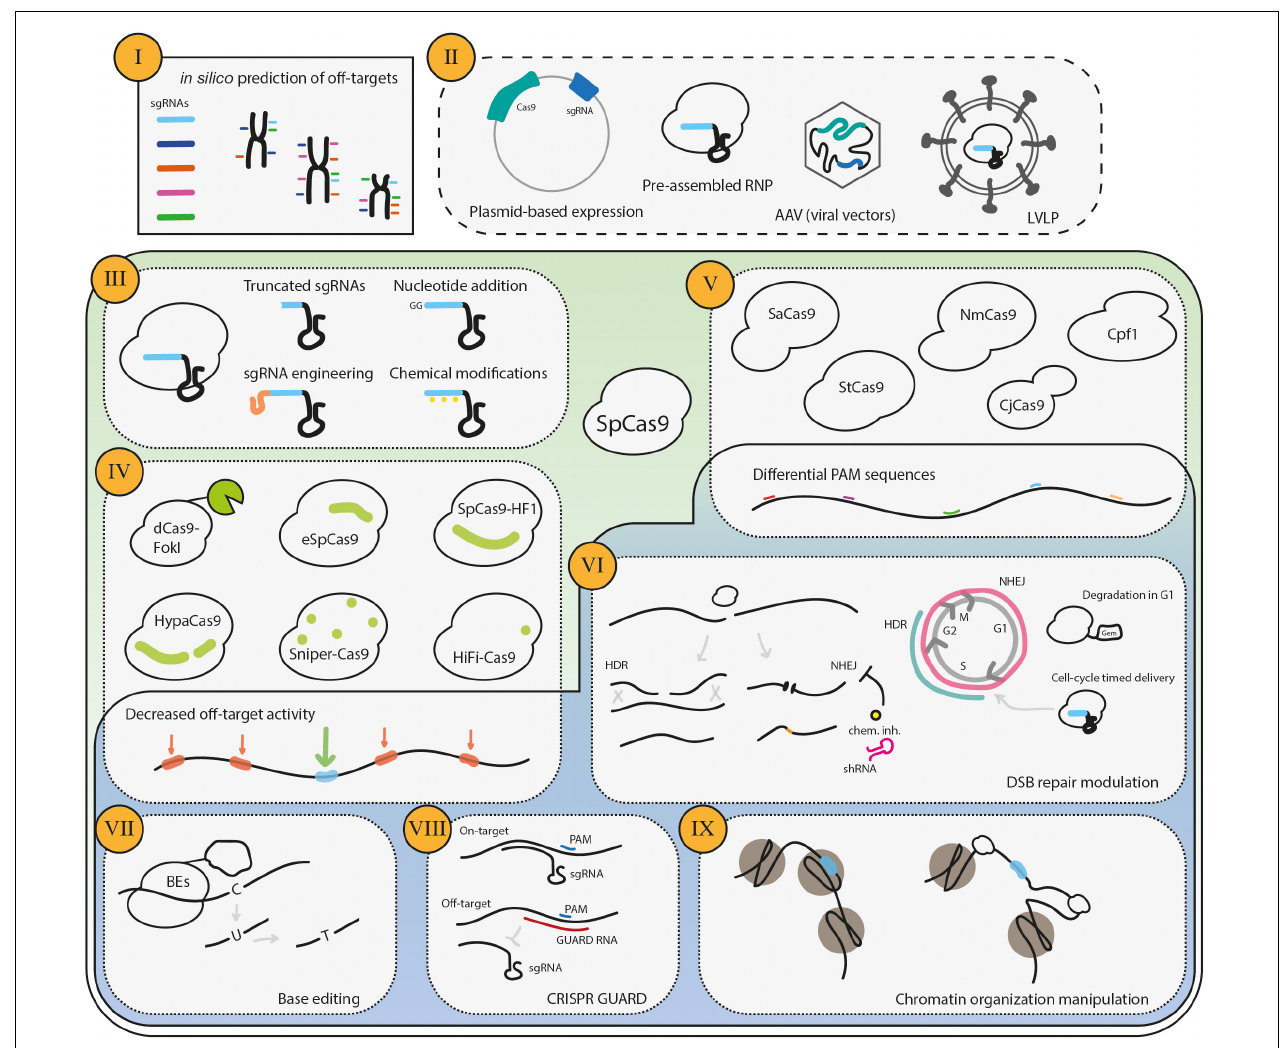
FIGURE 2 | Strategies to decrease CRISPR/Cas9 off-target activity. The procedures to mitigate undesired CRISPR/Cas9 gene editing start (I) in silico , namely in the design of the sgRNAs. Several bioinformatic tools are available to determine the predicted off-targets of a given sgRNA, and one should choose a sequence that has high theoretical on-target activity and a low probability of generating off-target DSBs. The second step is (II) the delivery type of the CRISPR/Cas9 system players, which determines how long the cell becomes exposed to the RNP complex. Furthermore, (III) the engineering of the sgRNAs is an efficient strategy to decrease off-target activity. One additional major focus has been to (IV) engineer the highly specific SpCas9 forms with decreased off-target activity. Moreover, (V) the SpCas9 orthologs have a repertoire of PAM specificities, which increases the options for suitable sgRNA and may also decrease the off-target activity if the complexity of the PAM is higher than that of SpCas9. (VI) Cas9-mediated DSBs may be repaired by the HDR or NHEJ pathways, which generate distinct repair products. As the HDR repairs the DNA damage restoring the original sequence, it has been argued and shown that the repair of off-targets by this pathway does not generate undesired gene edits. HDR repair is promoted either by pharmacological inhibition or cell-cycle-regulation. More recently, the use of Base Editors (VII) , where a catalytically dead Cas9 or a Cas9 nickase is fused to a cytidine deaminase that drives a single nucleotide modification, has the potential to reduce off-targets, due to sequence requirements and the lack of DSBs. The blockage of off-targets by GUARD RNAs (VIII) has also been shown to reduce off-targets of Cas9. Finally, (IX) the chromatin organization manipulation may skew the off-target